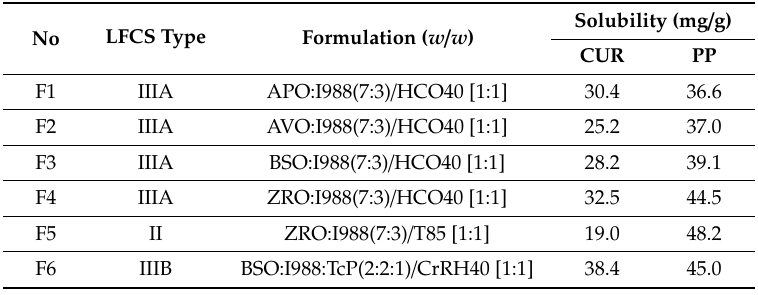
Table 2. Solubility of CUR and PP in various lipid-based formulations.